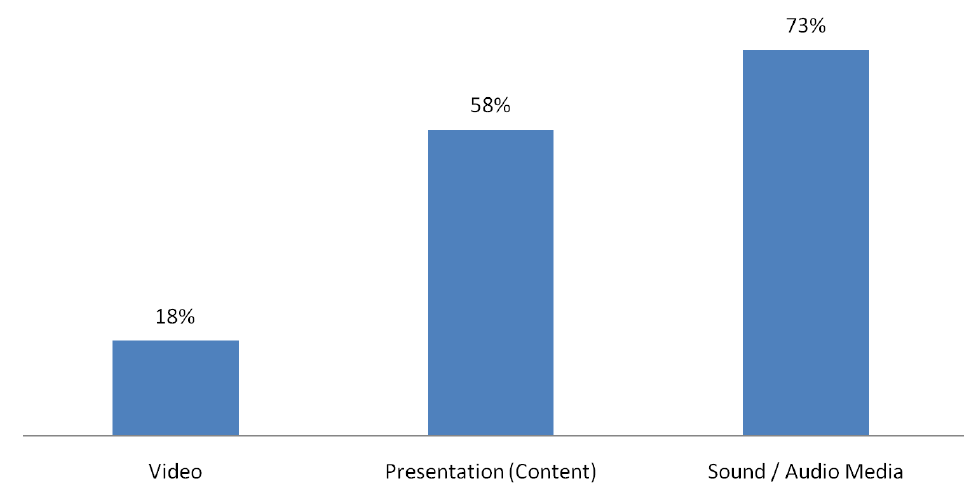
Figure 1. Grouped and adjusted qualitative data as quantitative data from the second part of the evaluation form in three categories.